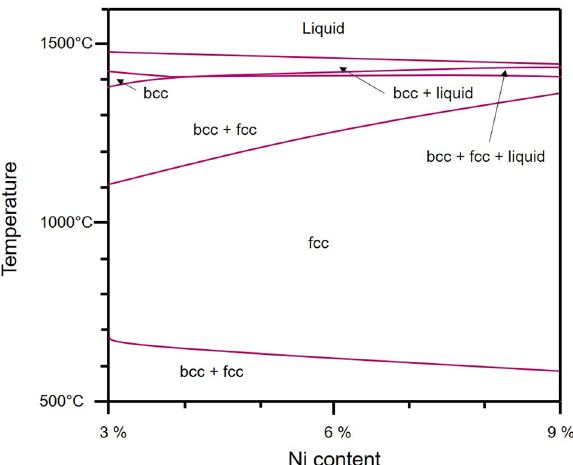
Figure 5. Calculated phase diagram of a CrMnNi steel with 16 wt.% Cr, 6 wt.% Mn and varying Ni contents (thermodynamic equilibrium). The carbon and nitrogen contents were set to 500 ppm and 400 ppm, respectively. The shift in phase transformation temperatures imposed by the high cooling rates being characteristic for the PBF-LB/M process is not considered. See text for